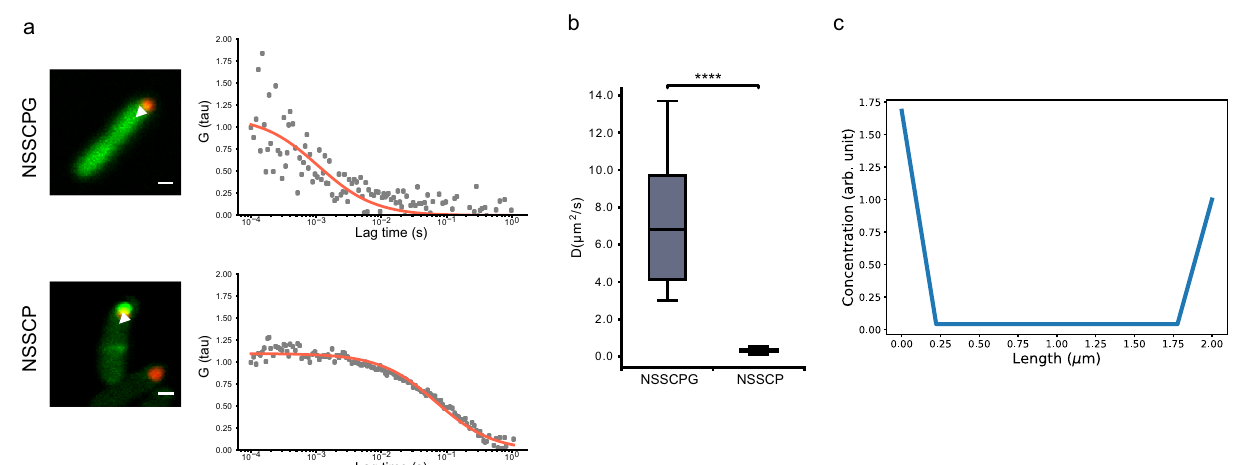
Fig. 5 Diffusion measurement and modeling con fi rm that asymmetry can arise with DivIVA as a reporter. a Representative images and FCS curves for NSSCPG (measuring freely diffusing sfGFP, top) and NSSCP (measuring DivIVA-sfGFP, bottom). Measurements were taken after SpmX Δ C-fused RNAP halves were induced from the P tac promoter with 50 μ M IPTG for 1 h. The white triangles indicate the locations for FCS measurements. In both plots, gray dots are the measured data points, whereas the solid orange lines indicate the fi tted functions. Scale bars: 1 μ m. b Mobility of the protein products. Diffusion coef fi cients were calculated from the fi t τ D ( “ Methods ” ) and the values were 7.23 ± 3.05 μ m 2 s − 1 ( n = 24) and 0.32 ± 0.1 μ m 2 s − 1 ( n = 23) for NSSCPG (freely diffusing sfGFP) and NSSCP (DivIVA-sfGFP), respectively. Center line, median; box limits, upper and lower quartiles; whiskers, 1.5× interquartile range. Statistical difference was determined by two-tailed Student ’ s t -test; **** denotes P < 0.0001. c Modeling results recapitulated the observed asymmetry (ratio between opposite poles: 1.68). This was aimed to recapitulate the averaged value for NSSCP in Fig. 4f; x = 0 marks the PopZ pole (localized source of DivIVA production). Source data are provided as a Source Data fi le.